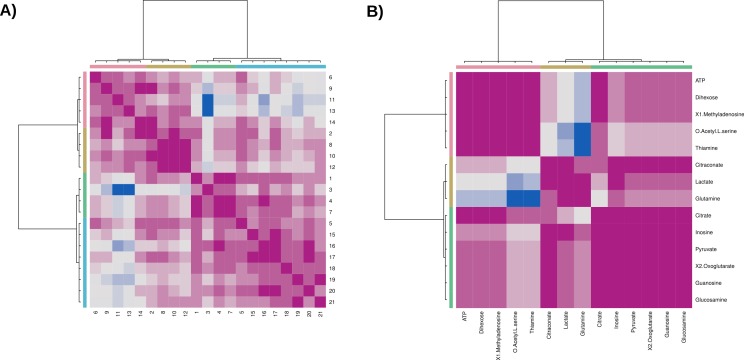
(A) Affinity propagation (AP) clustering and (B) AP clustering with transformed data matrix.